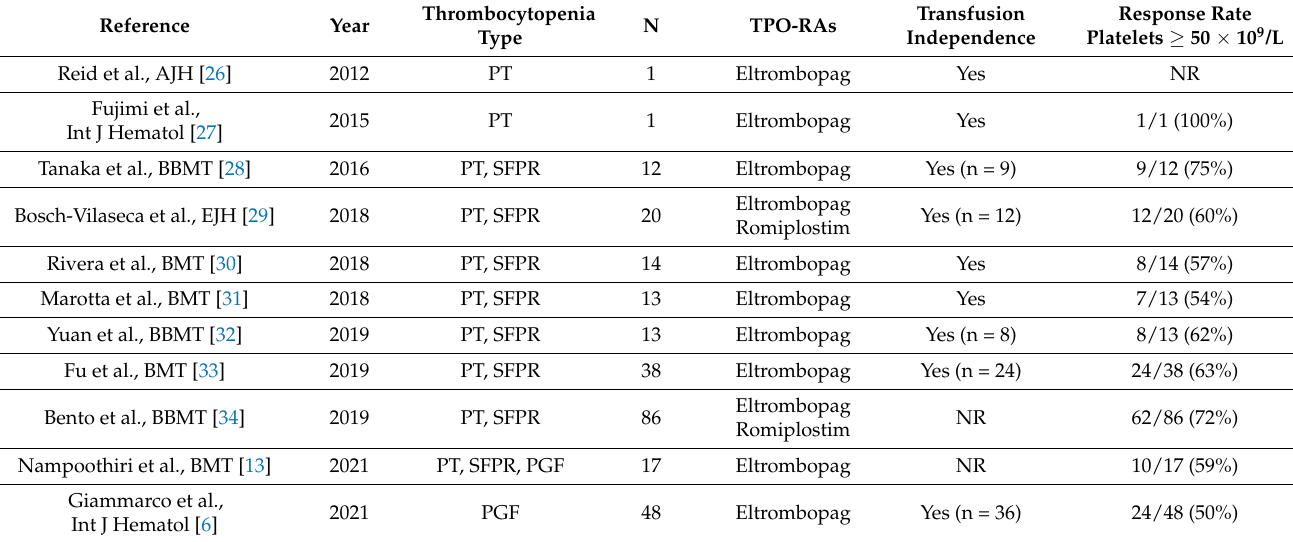
Table 1. Experience with Eltrombopag for persistent thrombocytopenia in an allo-SCT